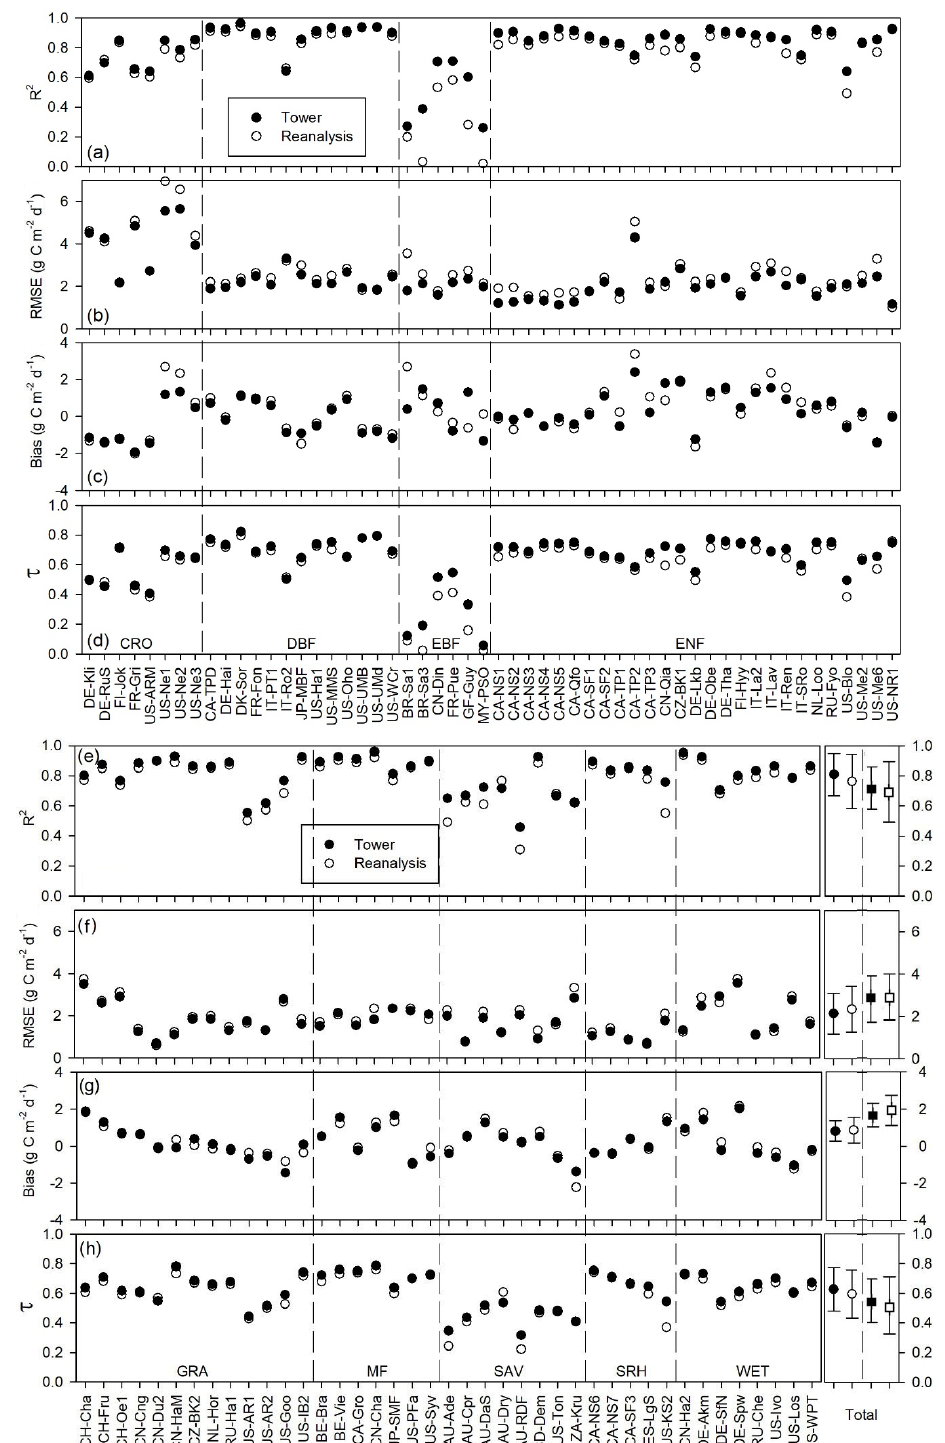
Figure 2. Comparisons of 8d mean GPP between the model-simulated GPP and tower-estimated GPP. Solid and open dots indicate the GPP simulations of the revised EC-LUE model derived from the tower-derived meteorology data and the meteorological reanalysis dataset, respectively; solid and open squares indicate the GPP simulations of the original EC-LUE model derived from the tower-derived meteorology data and the meteorological reanalysis dataset,